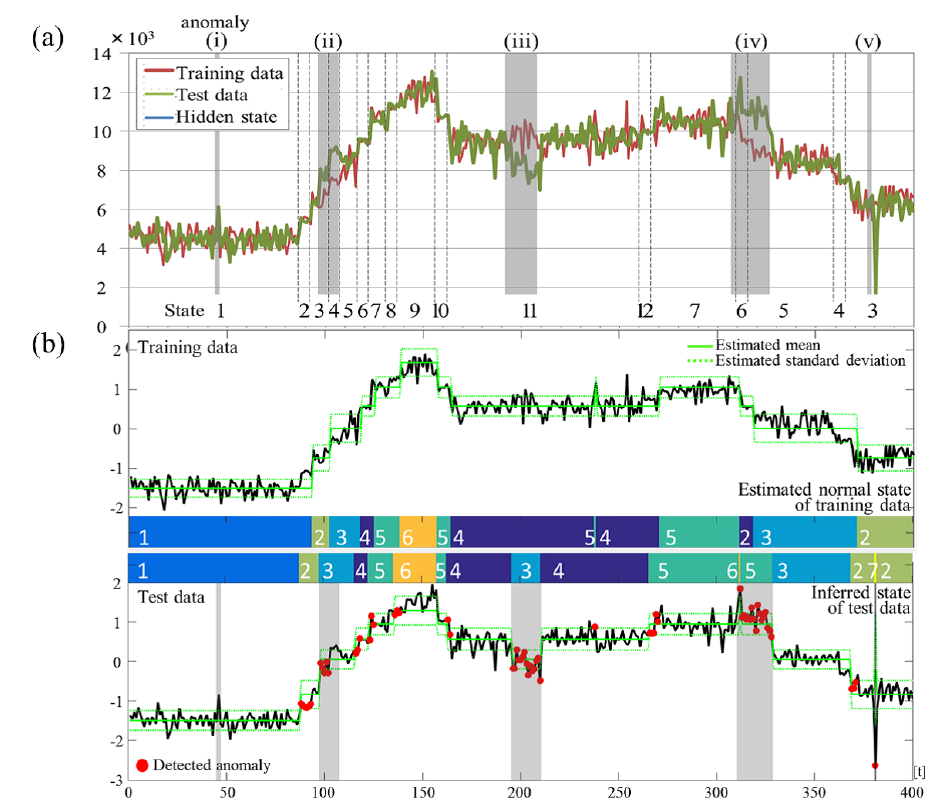
Figure 5: Synthetic training / test time-series data(a), inference and anomaly detection